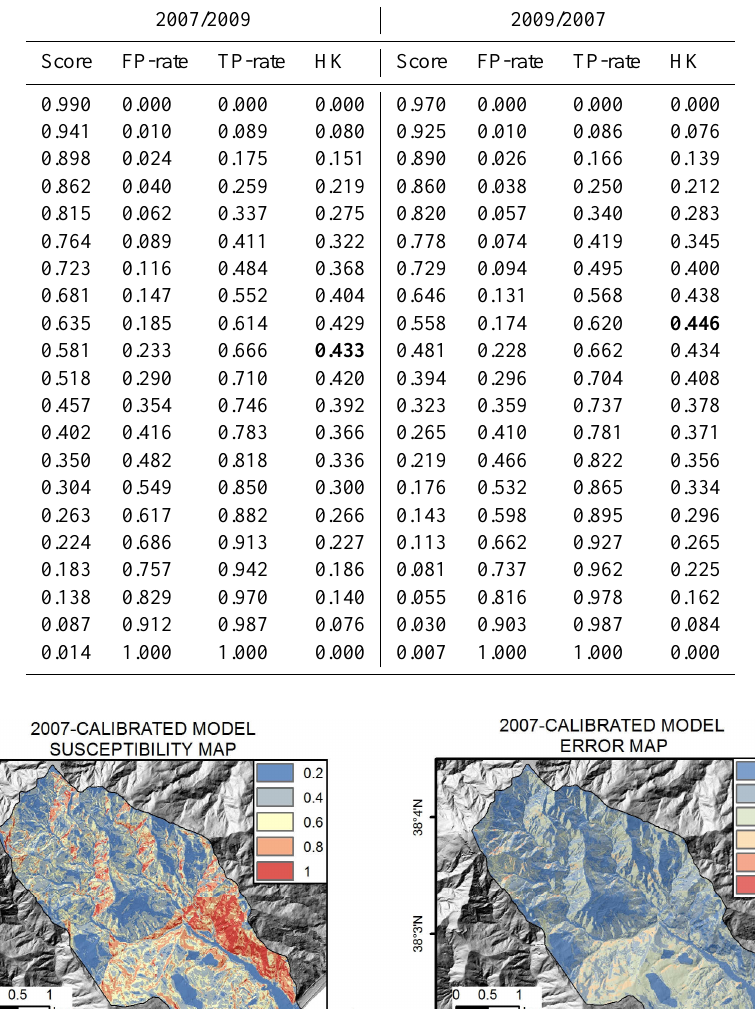
Table 3. HK values for the 100 replicated chrono-validations (in bold, the maximum values).